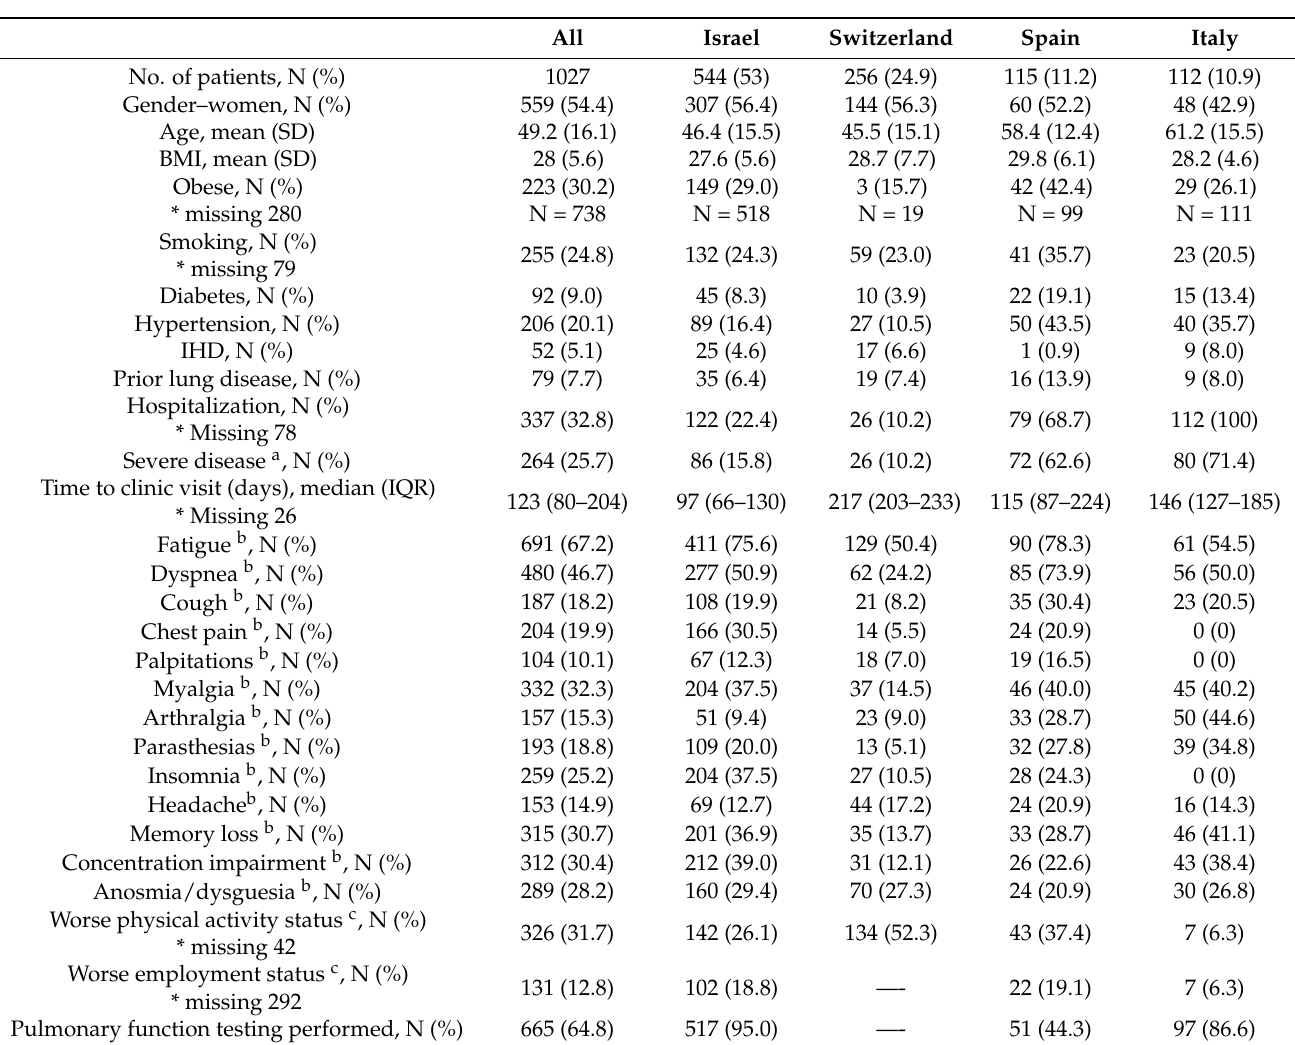
Table 1. Comparison of patient characteristics from the different centers.